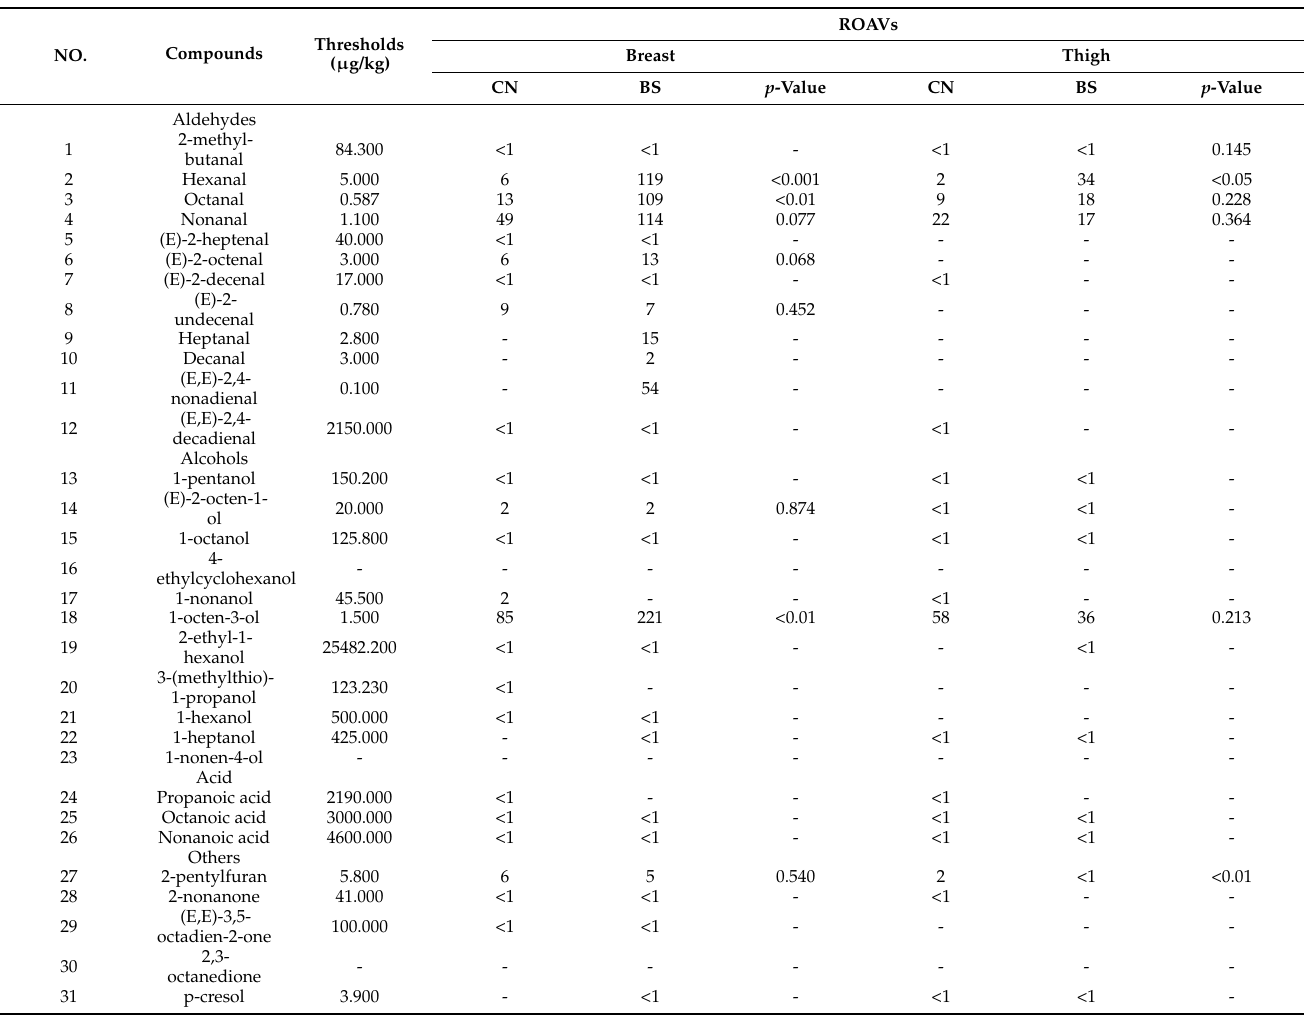
Table 8. The ROAVs of the volatile compounds of chicken